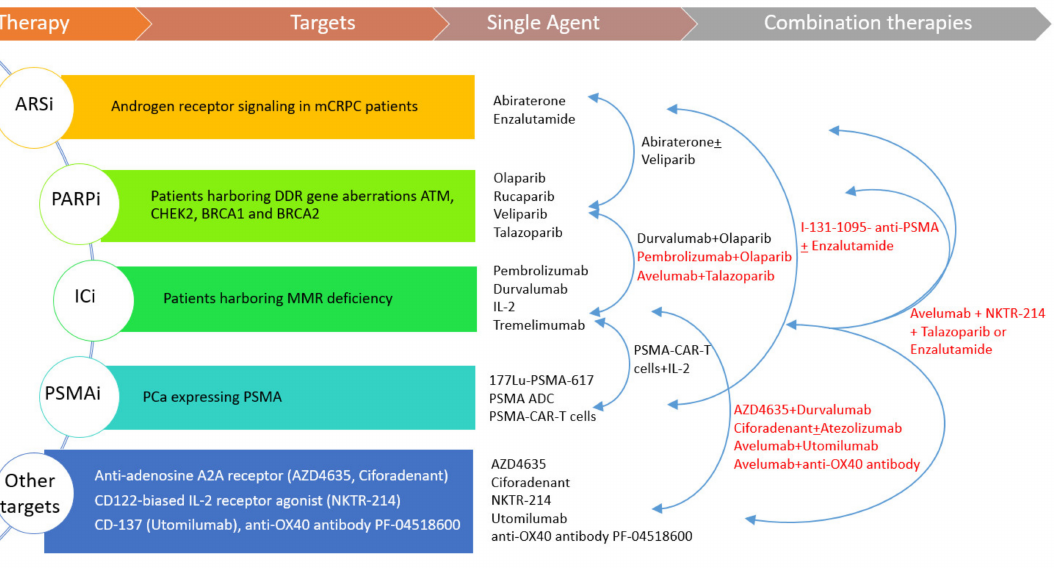
Figure 1. The figure shows the principal classes of therapies investigated in mCRPC patients, their molecular targets, and the single agents and combination therapies discussed (ongoing trials in